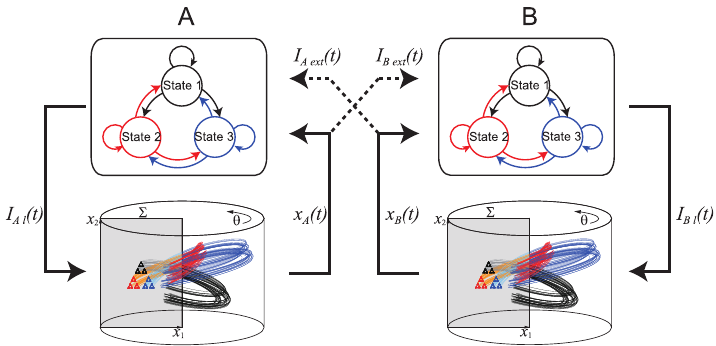
Figure 10. Schematic representation for two-coupled switching hybrid dynamics. This system is